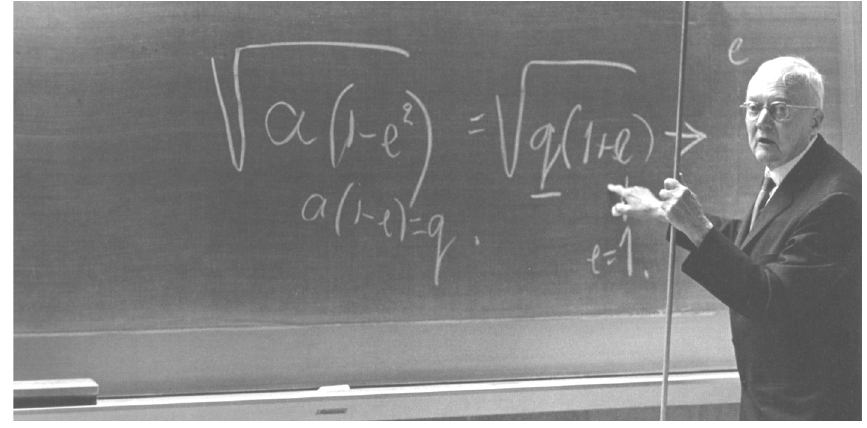
Fig. 2. ¨Opik giving a lecture at the University of Maryland in 1956 (Leppik